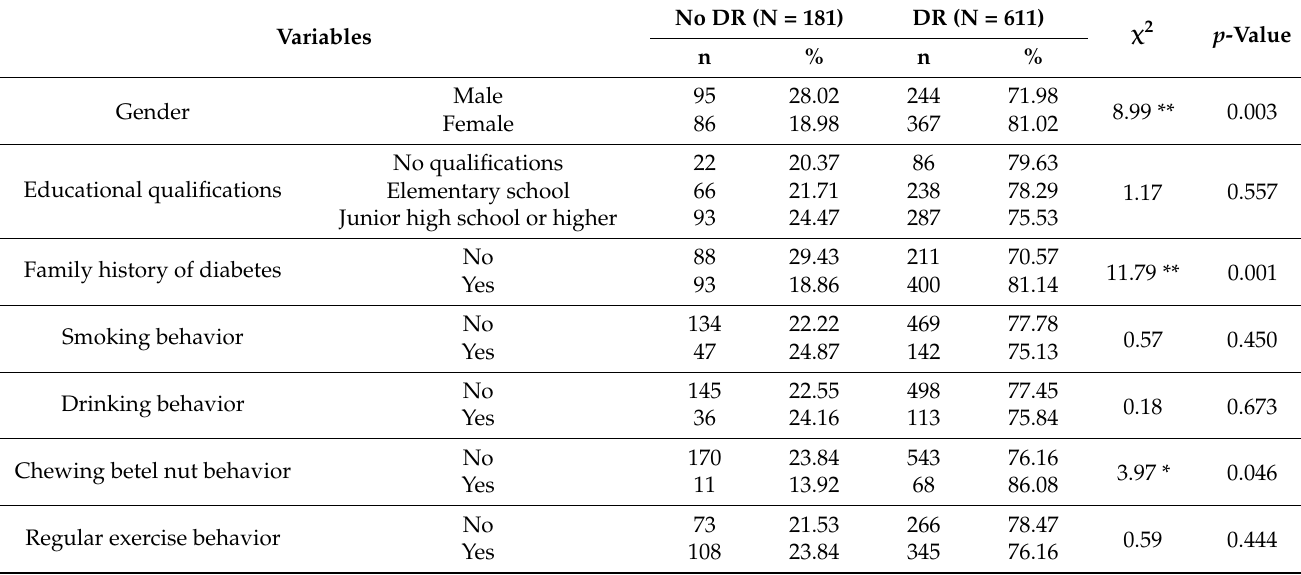
Table 1. Comparison of categorical variables between the patients with and without DR (N =